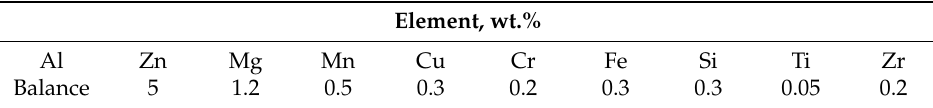
Table 1. Composition of